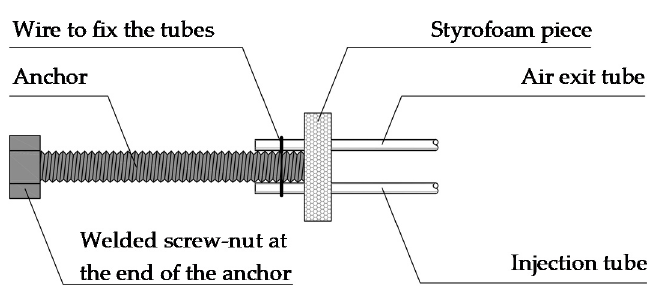
Figure 5. System used for the cementitious grout anchor. Adapted from [16].